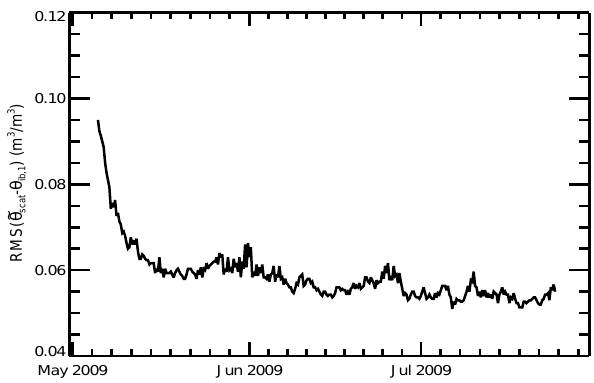
Fig. 5. Time series of RMS differences between ˜ θ scat and the UM level 1 volumetric soil moisture θ ib , 1 , from the Test experiment of trial 1. The statistics are calculated every six hours and the domain is the varying region covered by the ASCAT measurements during a six hour period.